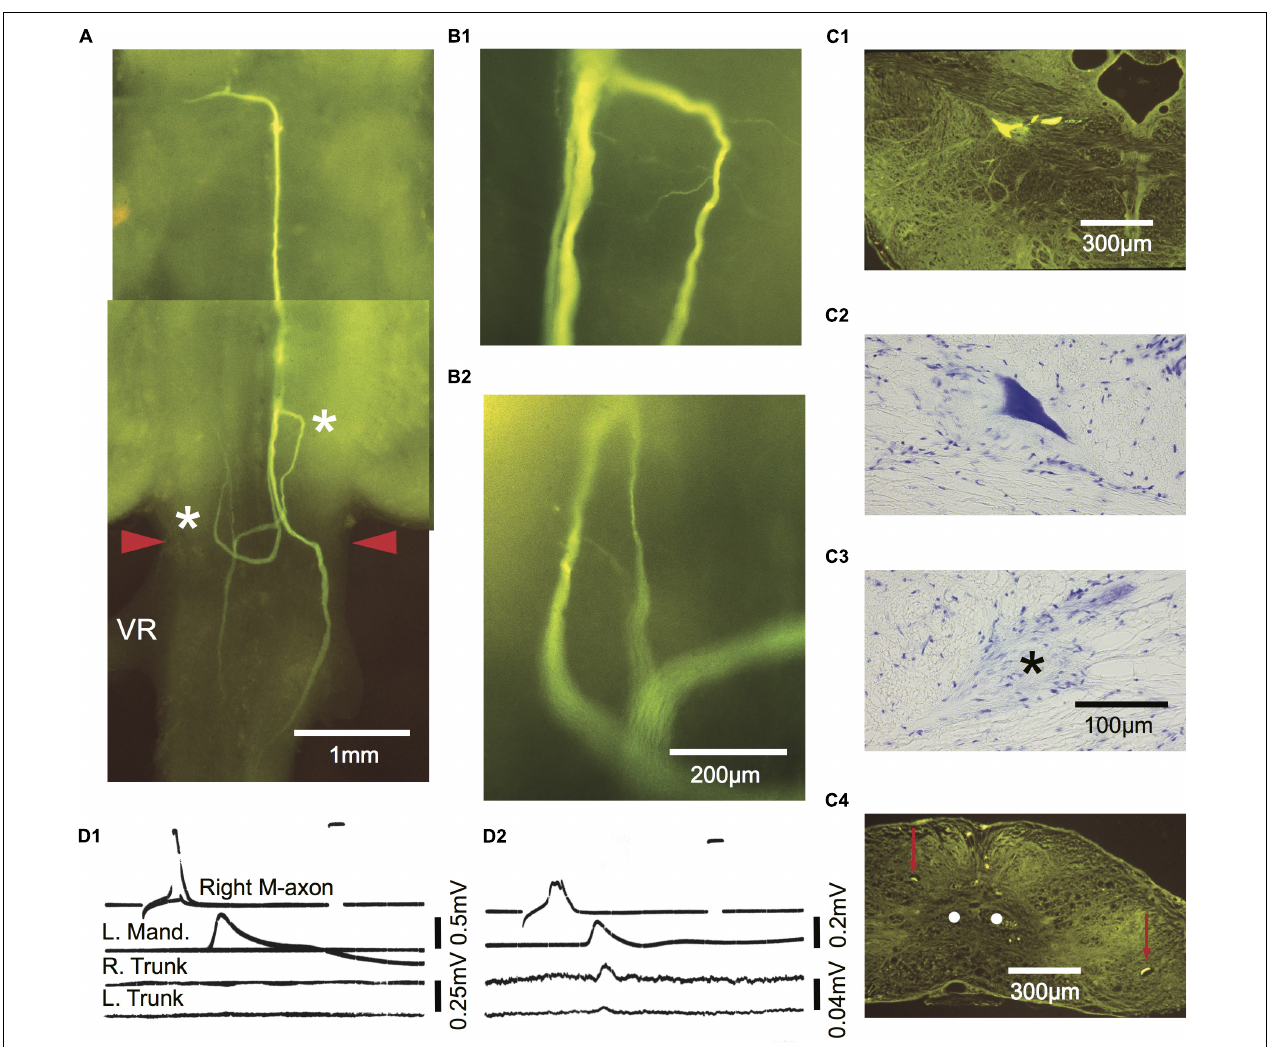
FIGURE 9 | Comparison of M-axon evoked EMG responses with regrowth patterns 434 days after a SML crush. Photographic montage of a Lucifer yellow-filled M-cell as seen in a brain wholemount. Three parent sprouts emanate from the M-axon. One remains ipsilateral and projects caudally. A second crosses the midline in the wound and projects both rostrally and caudally. A third crosses the midline, projects caudally, and then reverses direction rostrally at the anterior margin of the wound. The area to the left of the asterisk on the right side in panel (A) is enlarged in panel (B1) . The area to the right of the asterisk on the left side in panel (A) is enlarged in panel (B2) . A fine sprout appears to have a growth cone at its tip. (C1–C4) Cross sections of the wholemount brain shown in panel (A) . Left M-cell body filled with Lucifer yellow (C1) and stained with cresyl violet (C2) . (C3) An axon cap (*) was found at the former location of the right cell body. (C4) Cross section caudal to the wound site showing a sprout on the left and right of the spinal cord (red arrows) that corresponds to those seen in the wholemount. The sprouts are not located near the normal projection pathway of the M-axons (white dots). (D1,D2) Activation of the M-axon and EMG recordings from left mandibular and right and left trunk musculature. The recording in panel (D1) did not elicit a trunk response while somewhat later (D2) after the action potential had deteriorated, small EMGs were recorded in both the right and left trunk musculature.